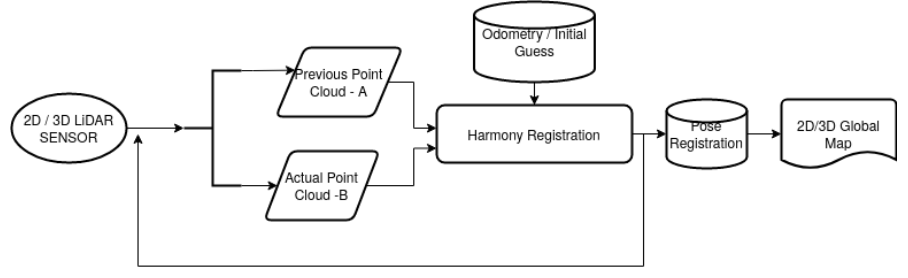
Figure 4. Implementation of